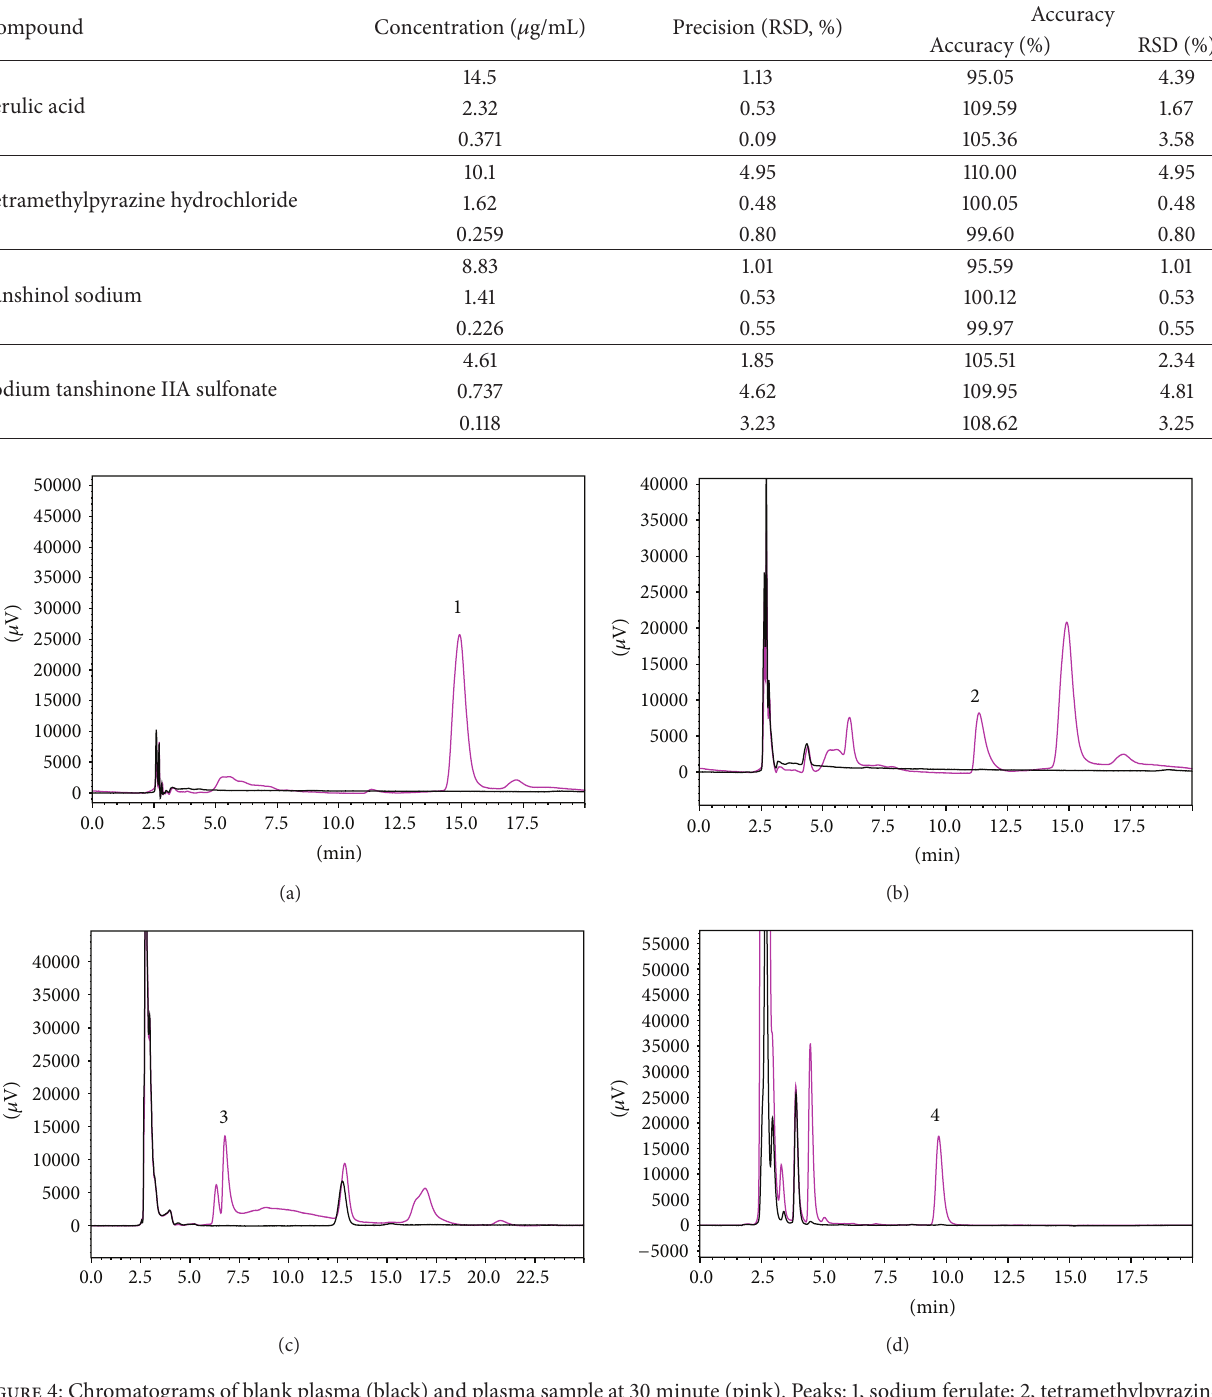
as Yangxue injection. The result showed a good corre- lation coefficient ( 𝑟 = 0.9994 ) for mixed drugs over the total concentration range from 0.26 to 33.18 𝜇